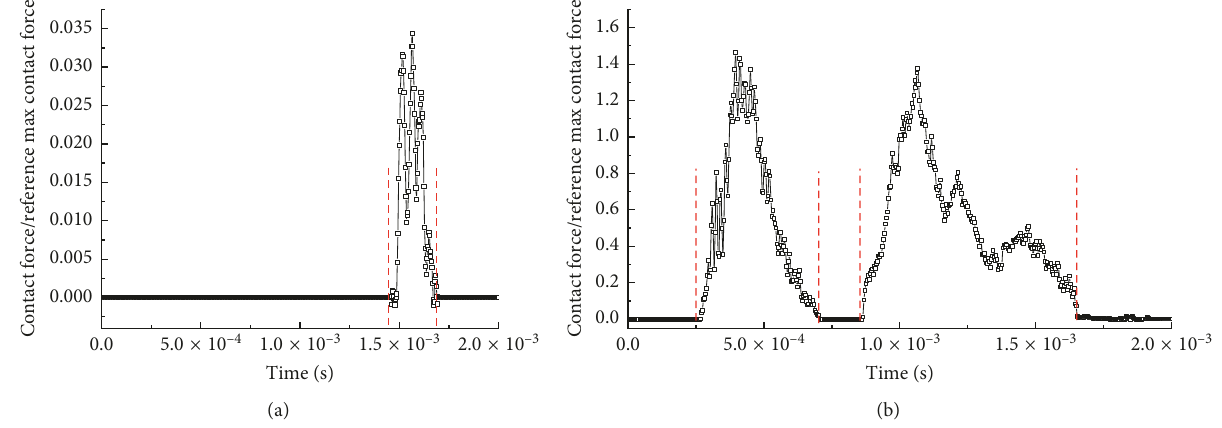
Figure 20: Comparison of the contact force on the casing in different imbalances: (a) 2.0g · cm; (b) 20.0g ·